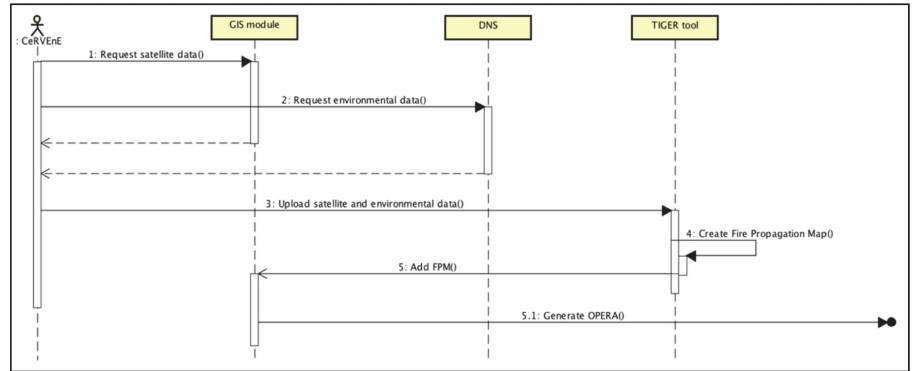
Figure 10. Sequence Diagram of the integrated ICT